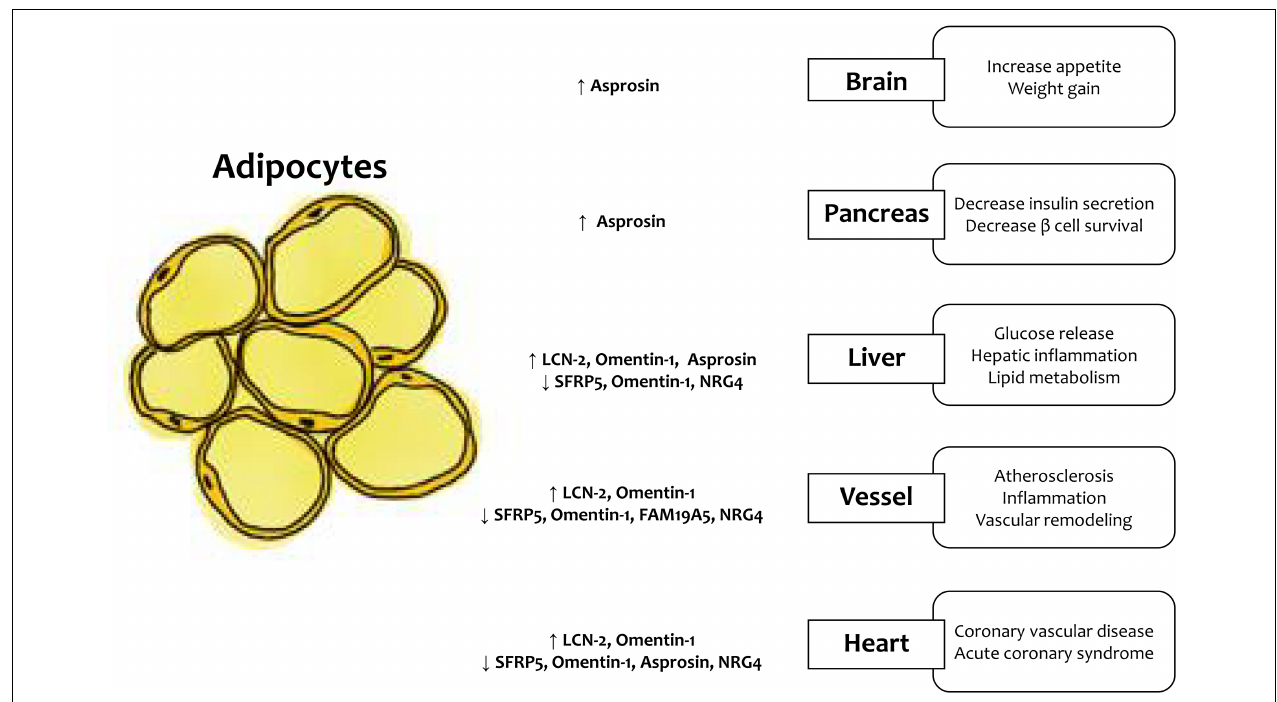
FIGURE 1 | LCN-2, lipocalin-2; SFRP5, secreted frizzled-related protein 5; NRG4, neuregulin